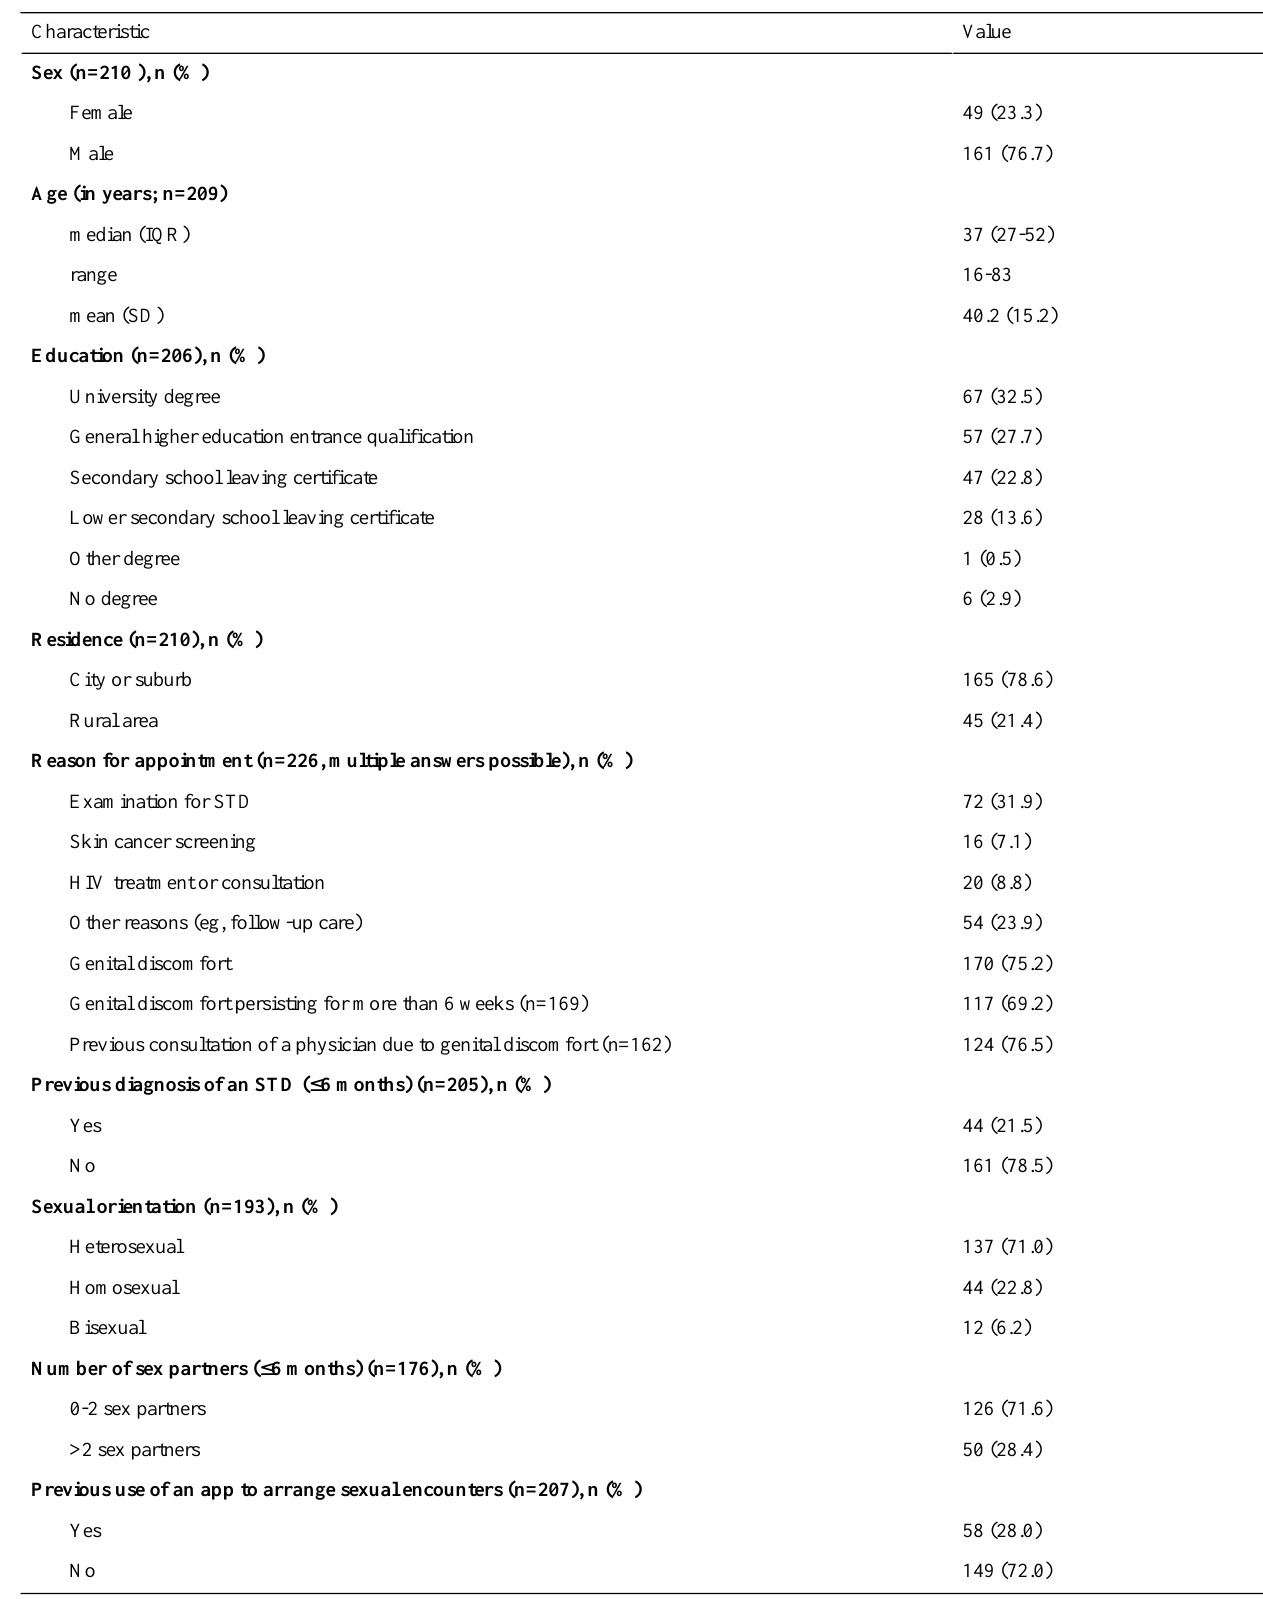
Table 1. Overview of the characteristics of the included patients in the cross-sectional study